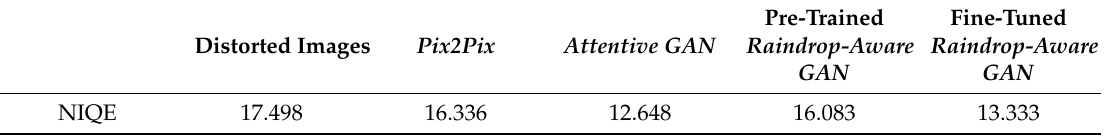
Table 3. Image-quality assessment on raindrop-contaminated video images taken from a CCTV that monitors coastal areas at Anmok Beach ( Anmok unpaired dataset